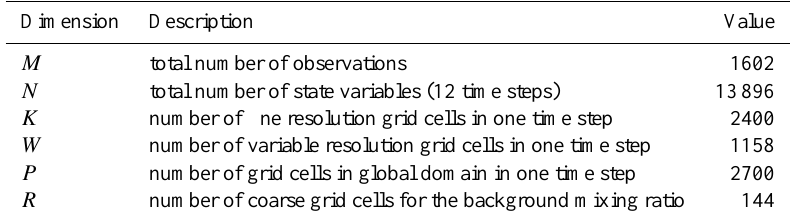
Table 2. Overview of the dimension notation and their values in the case study (test S1).